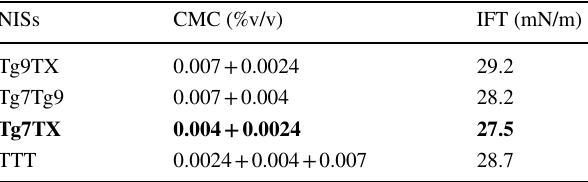
NIS Non Ionic Surfactants, CMC Critical Micelle Concentration, IFT Interfacial Table 5 IFT (mN/m) versus CMC (% v/v) of mixed NIS/NISs